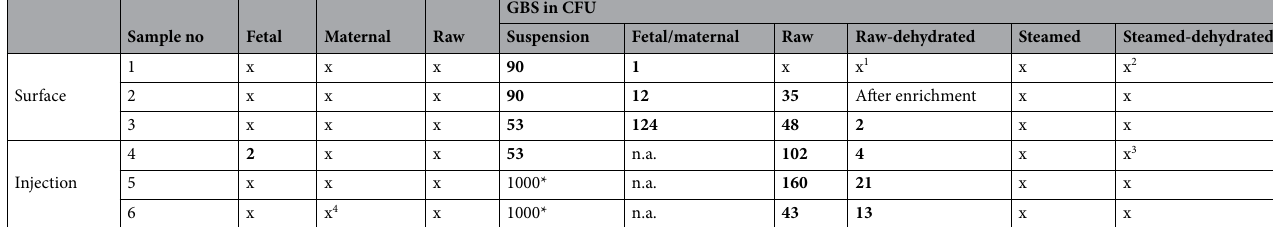
Table 4. Growth of GBS in colony forming units (CFU) from different swabs and on placenta tissue preparations. Further microorganisms were detected: 1 Bacillus spp. 1 CFU, 2 Staphylococcus epidermidis 1 CFU, 3 Bacillus spp. after enrichment, 4 Staphylococcus haemolyticus CFU 6. (x) no growth of GBS after 48 h; (*) bacteria per ml; (n.a.) not analyzed. Significant values are in bold.